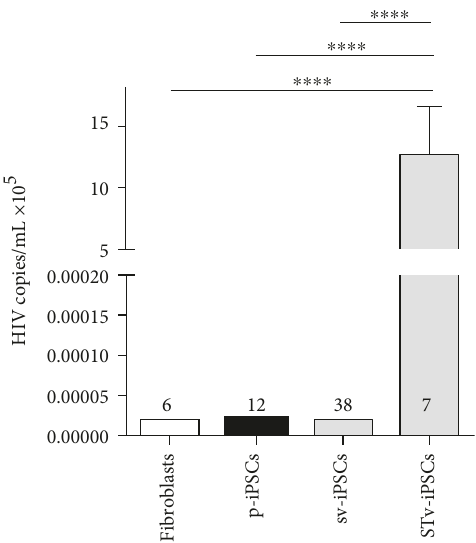
Figure 3: HIV-1 detection by a high-throughput PCR method in fi broblasts and iPSCs. STEMCCA-, Sendai-, and plasmid-based iPSC clones were tested for the presence of HIV-1. All STEMCCA-generated iPSC lines were positive for HIV with a titer of 12 67 × 10 5 ± 3 9 cp/mL. Fibroblasts (FB): n = 6 ; p-iPSCs (plasmid): n = 12 ; sv-iPSCs (Sendai virus): n = 38 ; STv-iPSCs (STEMCCA): n = 7 . n (numbers) are de fi ned as HIV detection experiments of di ff erent cell types and lines generated by the mentioned reprogramming